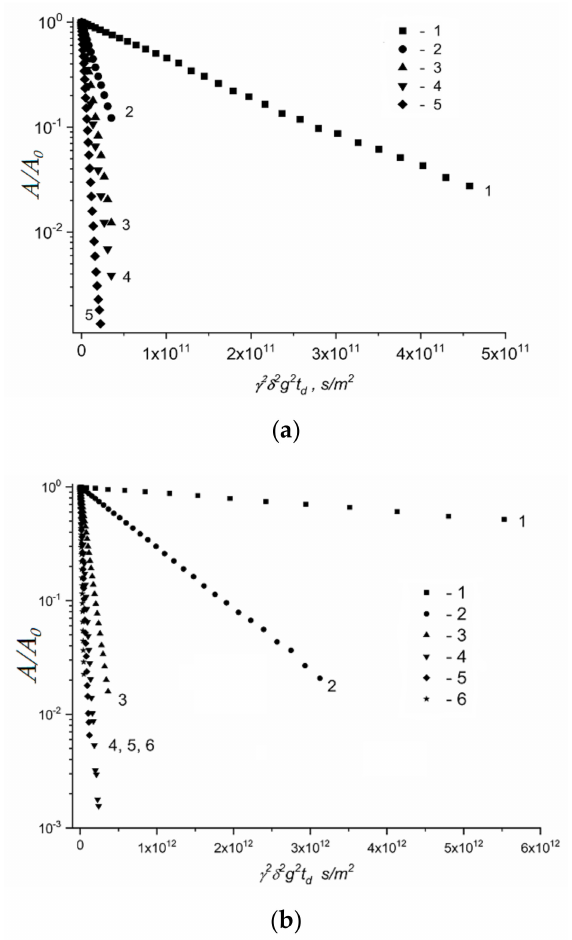
Figure 33. ( a ) Spin–echo signal attenuation of water molecule 1 H nuclei dependences on gradient pulsed amplitude A ( g ) (diffusion decay) in Li + ionic form of Nafion membrane at different water content: (1) λ = 2.0, (2) λ = 4.0, (3) λ = 5.7, (4) λ = 7.4, (5) λ = 10.7. ( b ) Spin-echo signal attenuation of 7 Li nuclei dependences on gradient pulsed amplitude A ( g ) (diffusion decay) in Li + ionic form of Nafion membrane at different water content: (1) λ = 0.9, (2) λ = 2.0, (3) λ = 4.0, (4) λ = 5.7, (5) λ = 7.4, (6) λ = 10.7. Reprinted with permission from [109]. Copyright 2021 Elsevier.